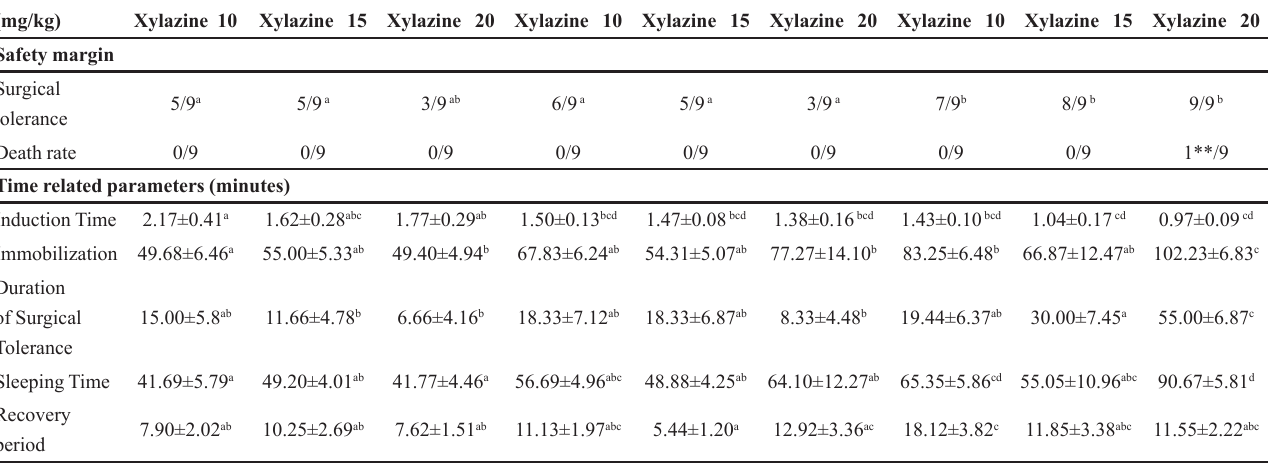
TABLE I - Comparison of safety, efficacy and time related parameters using different doses of ketamine/xylazine in BALB/c mouse